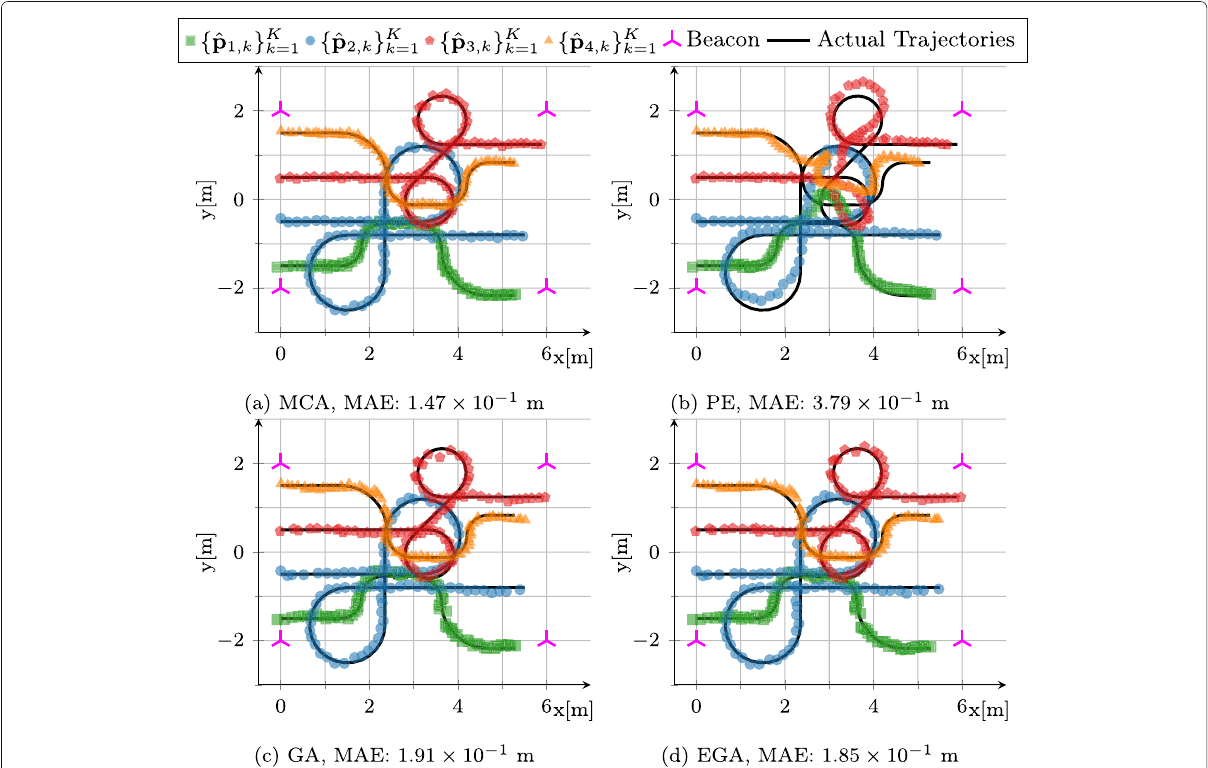
Fig. 6 Estimated averaged trajectories (markers only) for all methods, with the actual trajectories underlaid in black (cf. Fig. 2). These results were obtained for MNS 2 and 422 PPA